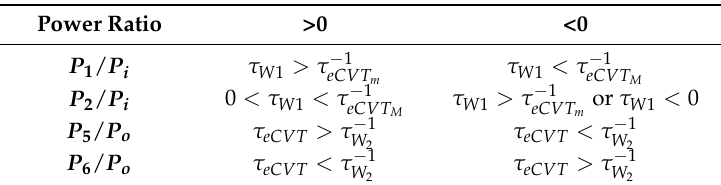
Table 3. Case 2—Power ratios